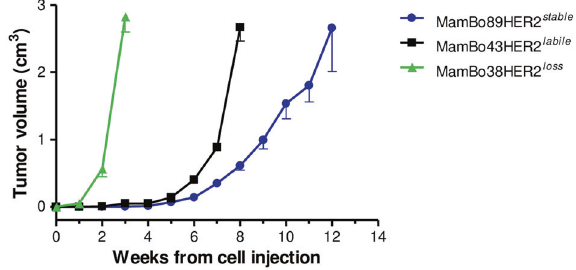
Fig. 3 In vivo growth of MamBo cell lines (after injection of 10 6 cells in m.f.p.) in FVBhuHER2 female mice. Cell lines: MamBo38- HER2 loss (green triangle), MamBo43HER2 labile (black square) and MamBo89HER2 stable (blue circle). Mean and SEM from 3 – 8 mice per group is shown. MamBo38HER2 loss growth was signi fi cantly faster, from 1 week after cell injection onwards, than MamBo43HER2 labile and MamBo89HER2 stable cell lines, p < 0.01 by unpaired t test with Welch ’ s correction. From 6 weeks after cell injection, MamBo43- HER2 labile cells also grew faster compared to the MamBo89HER2 stable cell line, p < 0.001 at 6-7 weeks and p = 0.068 at 8 weeks by unpaired t test with Welch ’ s